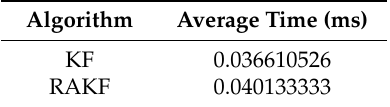
Table 4. Computational time of the heading estimation